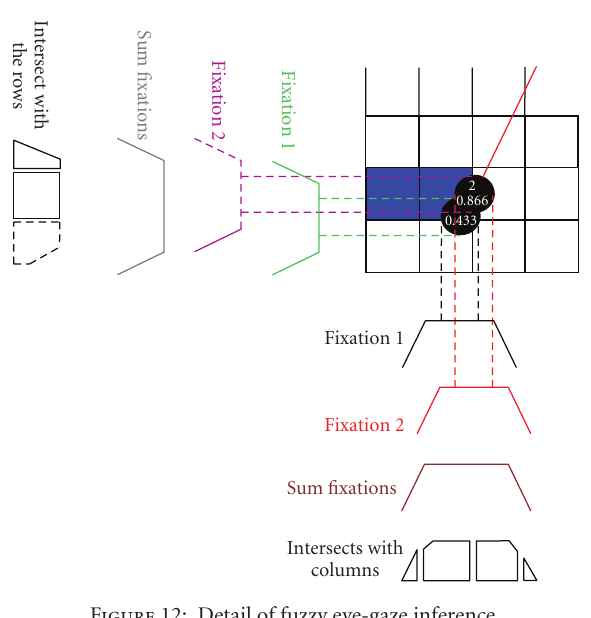
Figure 12: Detail of fuzzy eye-gaze inference.